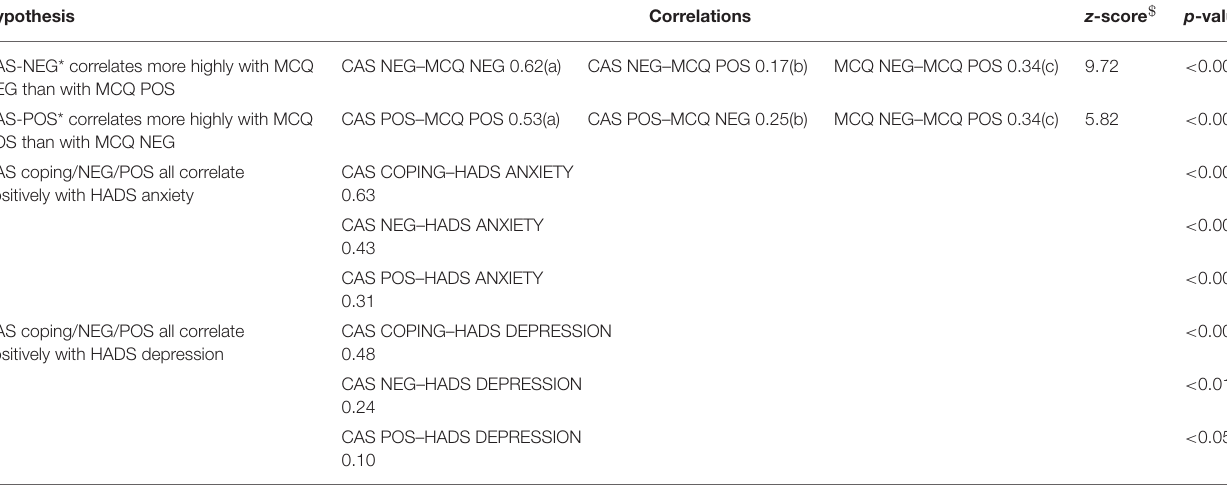
TABLE 5 | Summary of investigations of CAS-1R convergent and discriminant validity. Hypothesis Correlations z -score $ p -value CAS-NEG* correlates more highly with MCQ NEG than with MCQ